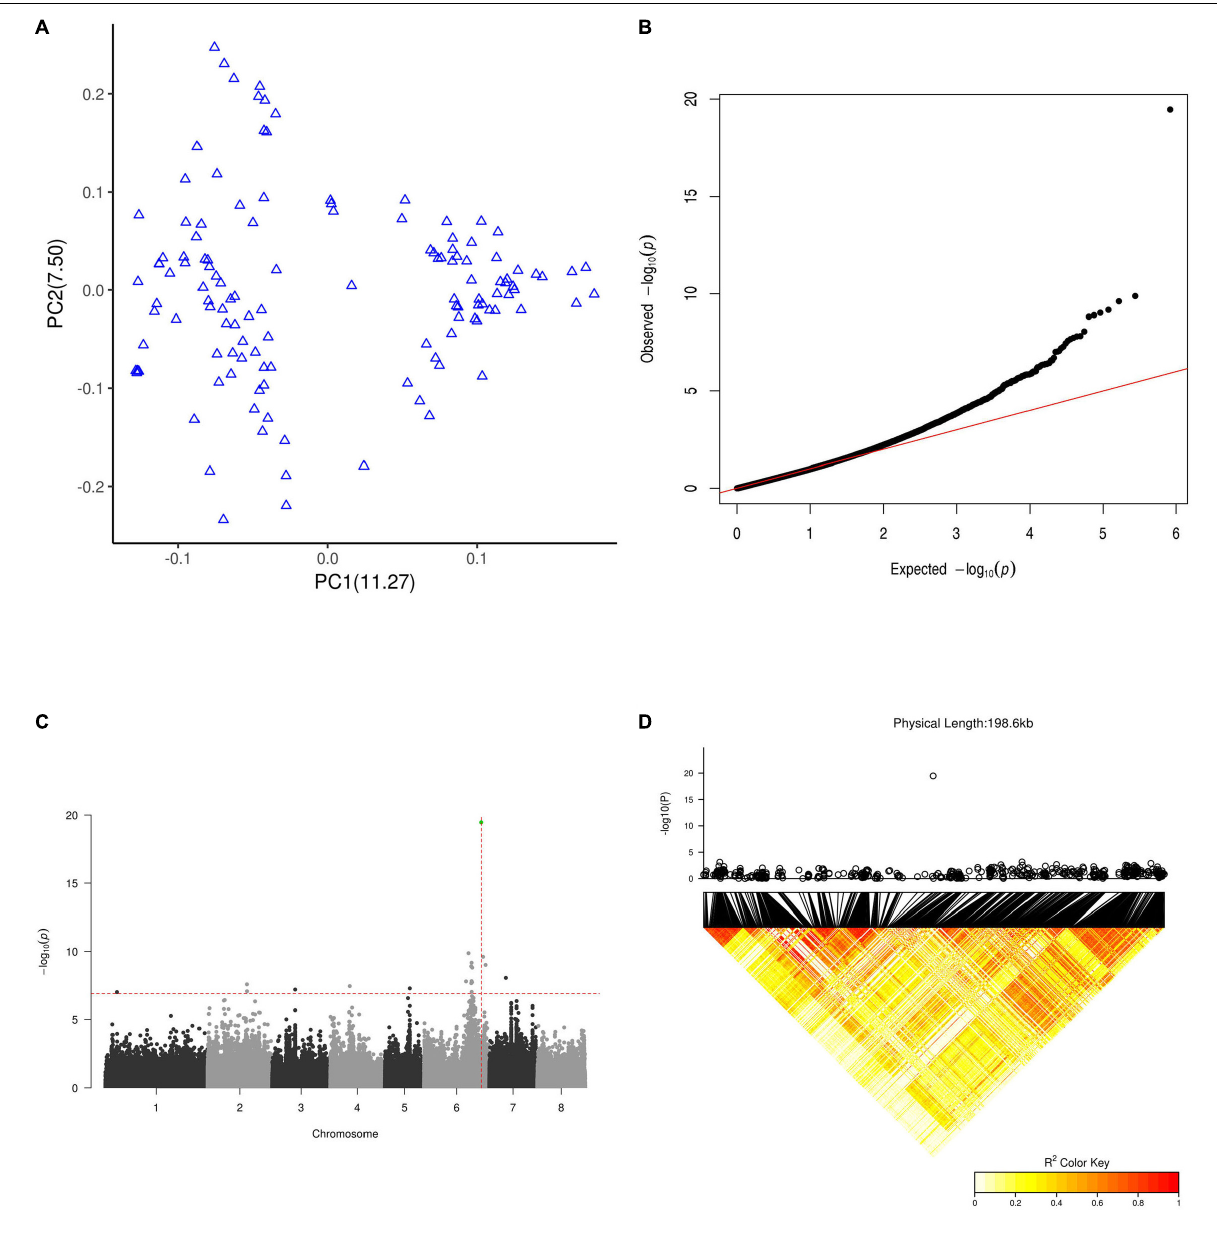
FIGURE 4 | GWAS results for flat fruit shape. (A) PCA plot for the 127 GWAS peach cultivars based on a whole-genome LD-reduced SNP set. PC1 and PC2 indicate the scores of principal components 1 and 2, respectively. Values in parentheses indicate the percentage of variance in the data explained by each principal component. (B) QQ plot of the GWAS on the flat fruit shape trait. (C) Manhattan plot of GWAS results for flat fruit shape. The X axis represents the longest 8 scaffolds of the peach genome. The horizontal dashed line is the threshold value after abbirdx-adjustment ( P = 7.2). The vertical dashed red line shows the location where the association signal was the most significant ( P = 19.8). The green dot shows the SNP at 26,924,482 of scaffold Pp06 with the most significant signal. (D) LD pattern of SNPs within a 200 k flanking interval of the SNP at position 26,924,482 of scaffold Pp06. The top panel shows a local 200 k Manhattan plot for peach fruit shape surrounding the SNP at position 26,924,482 of scaffold Pp06. The bottom panel shows the LD pattern of SNPs within a 200 k interval surrounding the SNP at position 26,924,482 of scaffold